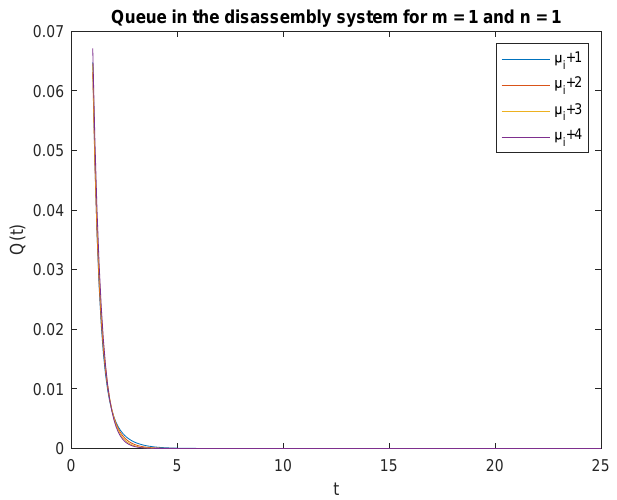
Figure 15. Impact of disassembly rate on probability P { X ( t ) = 1 | X ( 0 ) = 1 } for λ =